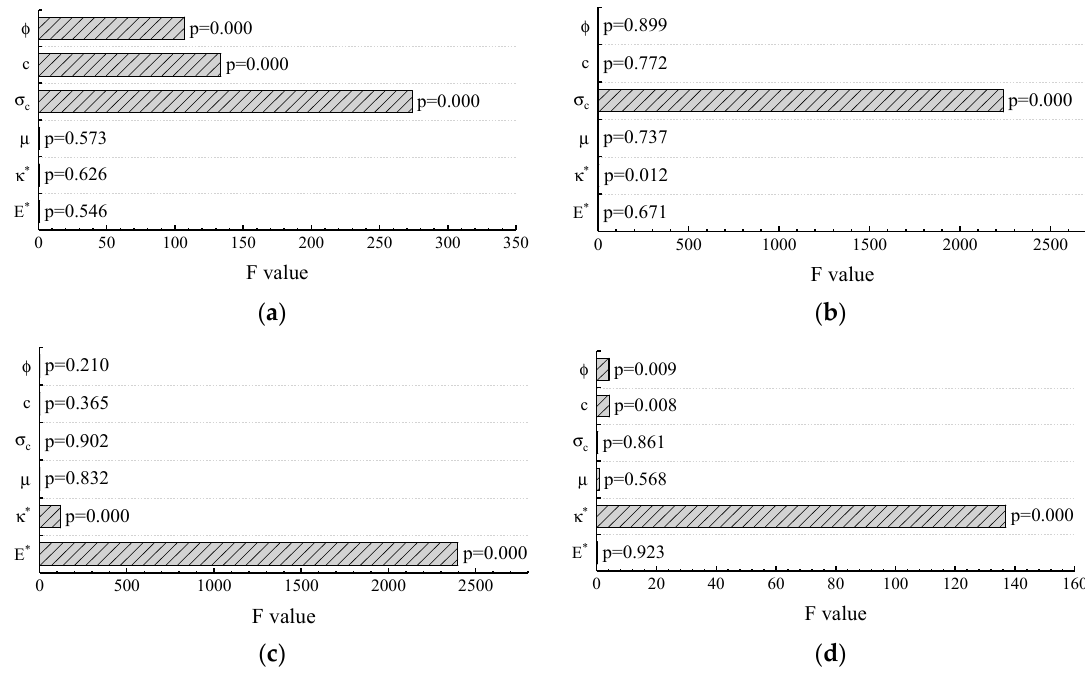
Figure 10. Results of a multifactor ANOVA ( α = 0.05): ( a ) unconfined compressive strength; ( b ) tensile strength; ( c ) elastic modulus; and ( d ) Poisson’s ratio. Table 3. Tested values of micromechanical